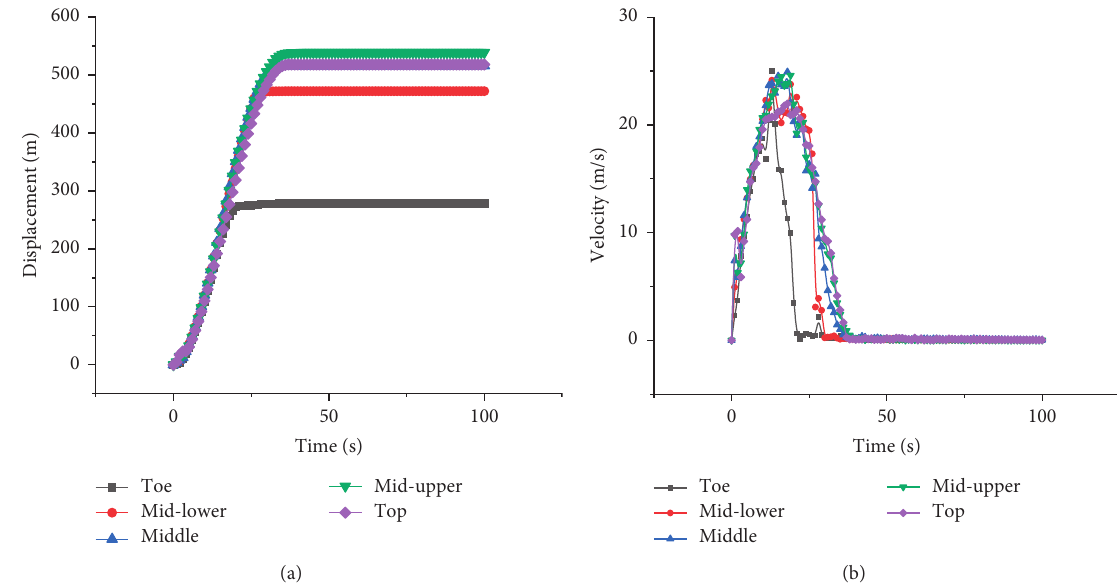
Figure 19: Typical monitoring quantities (number of particles: 11700). (a) Displacement-time curve at the 5 positions on the slope. (b) Velocity-time curve at the 5 positions on the